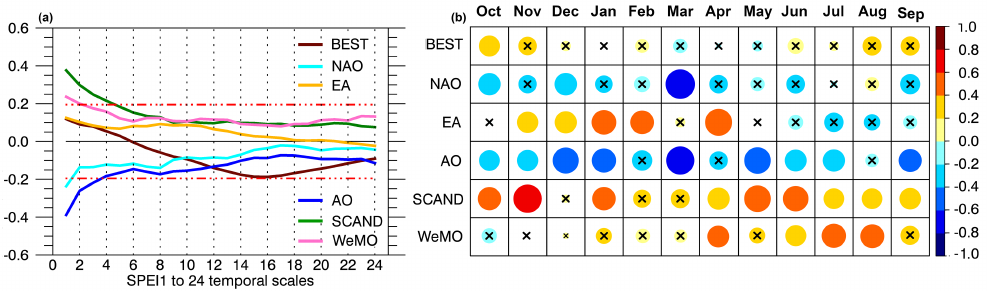
Figure 15. Correlation between the monthly series of the bivariate El Niño–Southern Oscillation (BEST), North Atlantic Oscillation (NAO), East Atlantic pattern (EA), Arctic Oscillation (AO), Scandinavian pattern (SCAND), and the Western Mediterranean Oscillation (WeMO) with (a) monthly series of the SPEI1 to the SPEI24 and (b) the monthly correlation between the same climatic indices and the SPEI1 for the period of 1980–2017. Statistically non-significant correlations at the 95% confidence level are those within discontinuous red lines in (a) and marked with an x in (b) . The size of each circle is proportional to the correlation